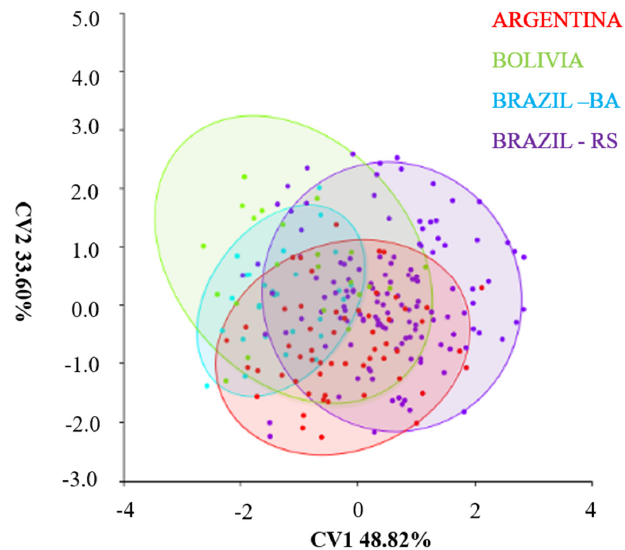
Figure 10. Exploratory analysis based on the shape variation of T. infestans heads from different regions after generalized analysis of Procrustes. Argentina (TI25, TI26) Bolivia (TI165), Bahia/ Brazil/ Residual foci 2010 (TI169); Rio Grande do Sul Brazil (TI24, TI 27, TI28, TI131, TI156).